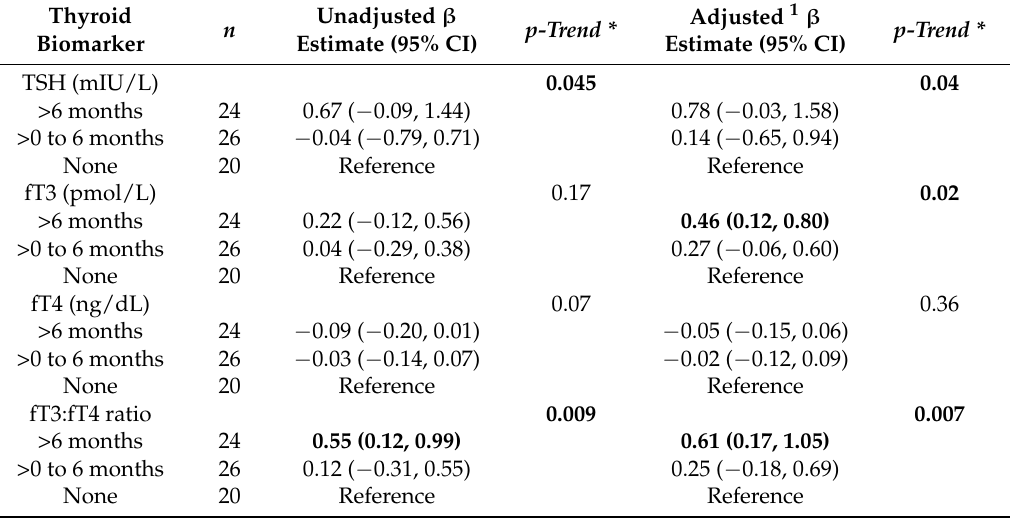
Table 4. Thyroid biomarker levels 9 to 16 years postpartum according to lactation history among women with a history of gestational diabetes who had a single lifetime pregnancy, Diabetes & Women’s Health